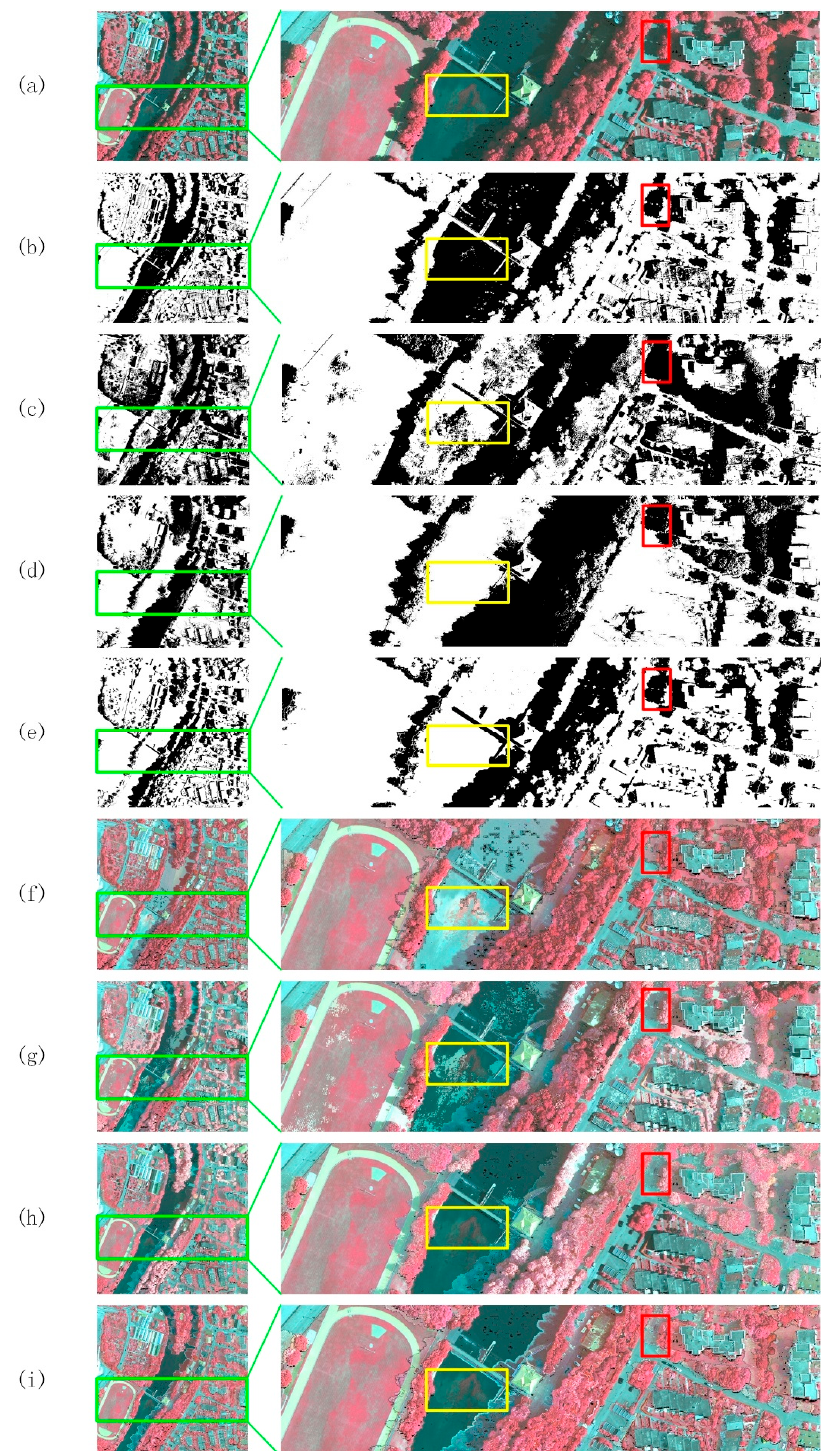
Figure 5. Results of the shadow detection and removal methods in test 1, and zoomed images of the green boxes: ( a ) original imagery; ( b ) result of TSM; ( c ) result of LMM; ( d ) result of the proposed method; ( e ) manually selected shadow mask; and ( f – i ) shadow compensation results based on the shadow masks in ( b – e ).